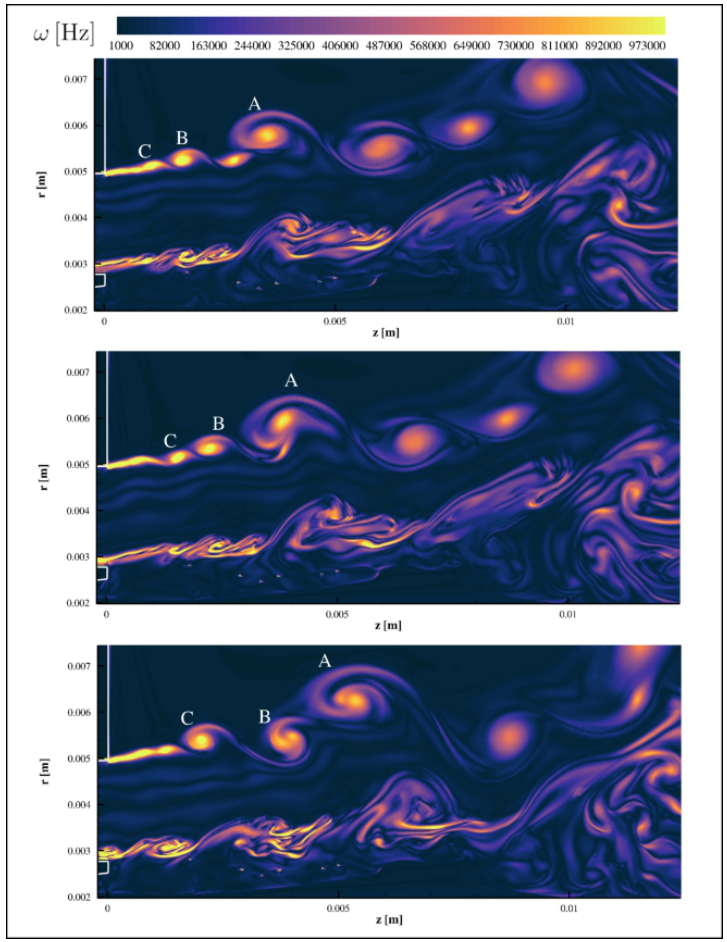
Figure 15. Instantaneous fields of vorticity module at the same times as Figure 11 close to the injection; three coherent structures are marked with the labels A, B, C. The delay time between each frame (from top to bottom) is ∼ 5.74 µ s. The three frames nearly cover a vortex shedding period ( ∼ 11.48 µ